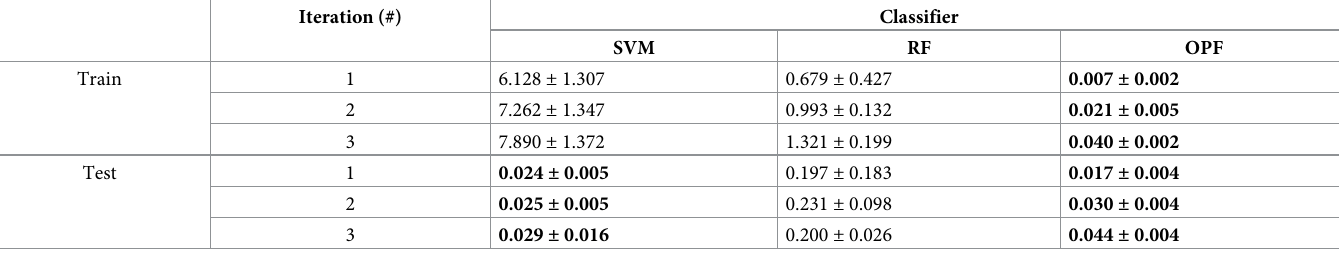
Table 4. Average computational times and standard deviations (in milliseconds) per iteration for the training and testing processes, using the supervised classifiers for the E.coli dataset. The best results (shorter times) are highlighted in bold.